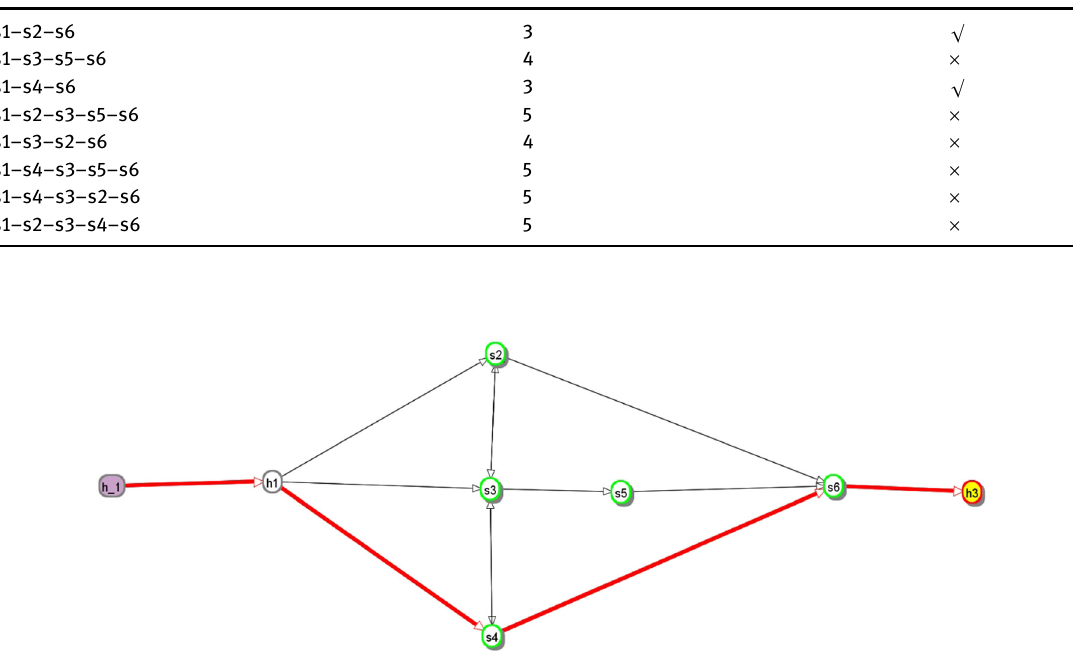
Table 3: Path discovery and selection Path discovery Hops Path selection